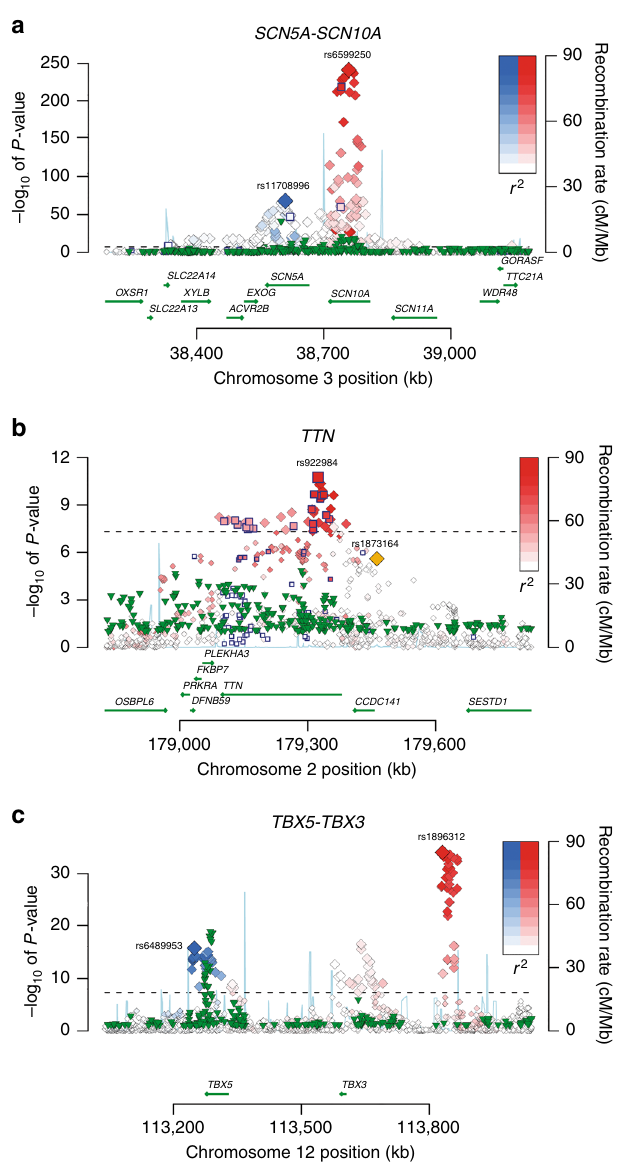
Fig. 2 Regional association plots of speci fi c loci associated with PR interval. Each SNP is plotted with respect to its chromosomal location ( x axis) and its P value ( y axis on the left). The blue line indicates the recombination rate ( y axis on the right) at that region of the chromosome. Blue outlined squares mark non-synonymous SNPs. Green triangles depict association results of the African Americans meta-analysis, only SNPs with P < 0.1 are shown. a Locus 2 and 3 ( SCN10A – SCN5A ) on chromosome 3. The index SNPs for the two genes are named with their rs-numbers and highlighted with two different colors (blue and red). Other SNPs in linkage disequilibrium with the index SNP are denoted in the same color; color saturation indicates the degree of correlation with the index SNP. b Locus 19 ( TTN ) on chromosome 2; and c Locus 9 and 10 ( TBX5 – TBX3 )